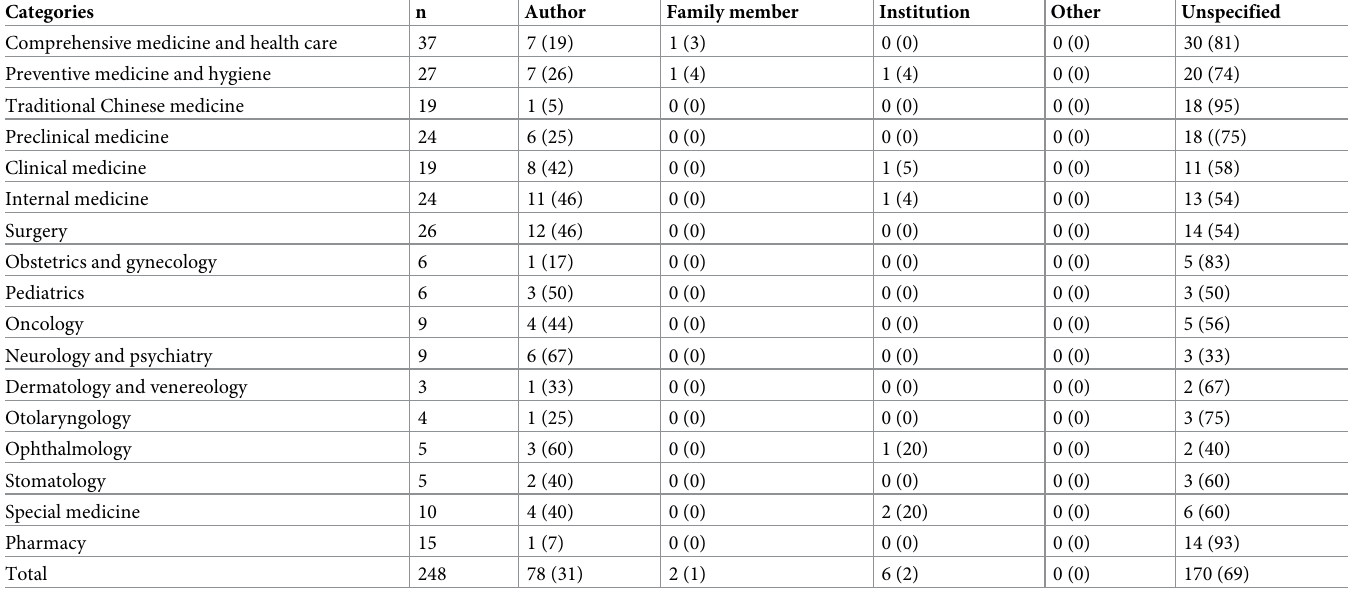
Table 3. COI subjects involved in research [n (%)].